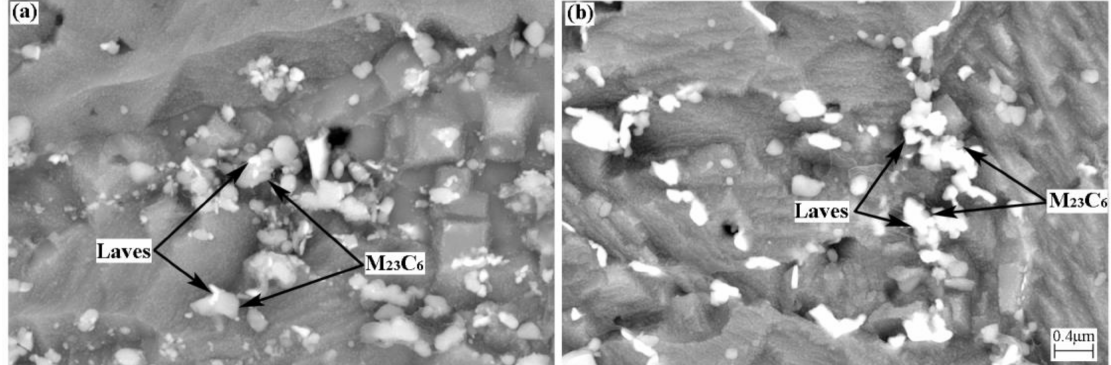
Figure 11. BSE image of BM with different creep times: ( a ) 9 h; ( b ) 114